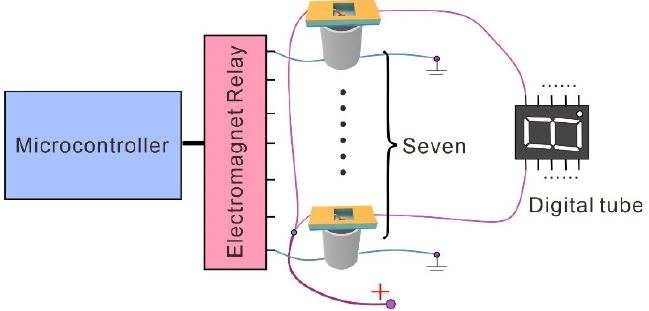
Figure A4. Photos of the beam electrode.